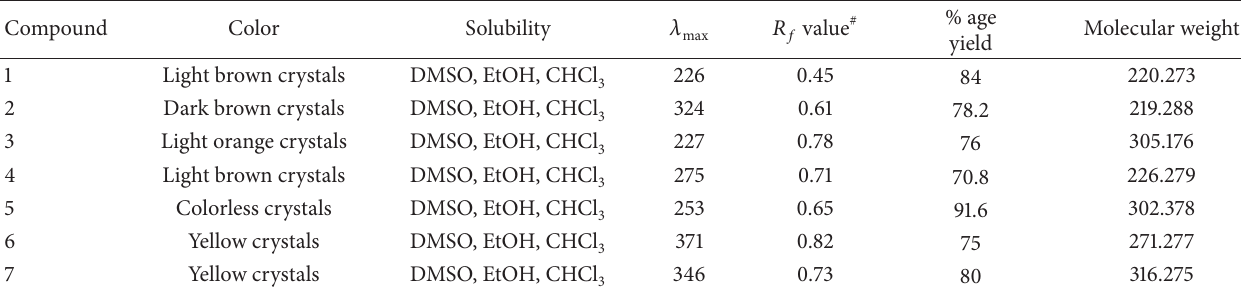
Table 1: Physical data of synthesized benzamide substituted Mannich